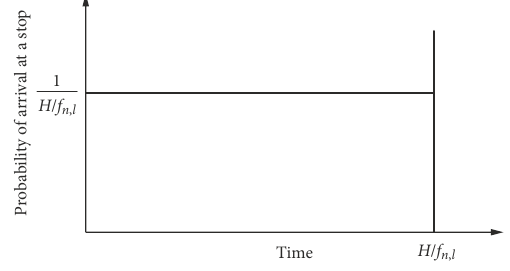
Figure 2. Small allocation interval passenger arrival